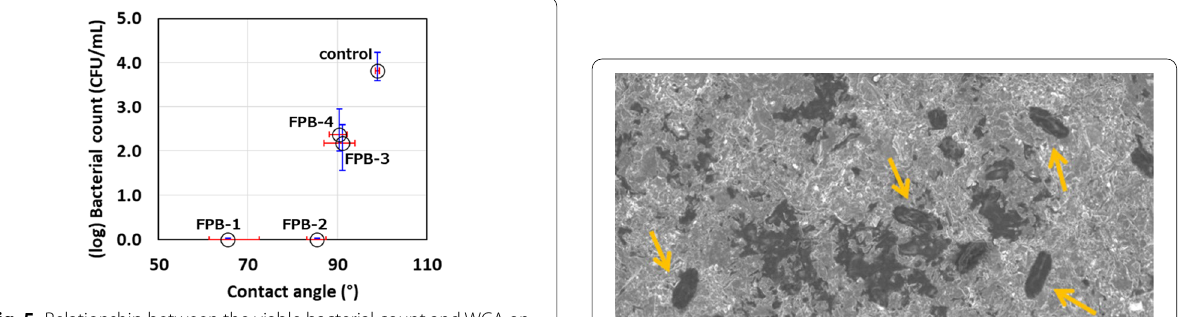
Fig. 5 Relationship between the viable bacterial count and WCA on the control and FPB-treated surfaces